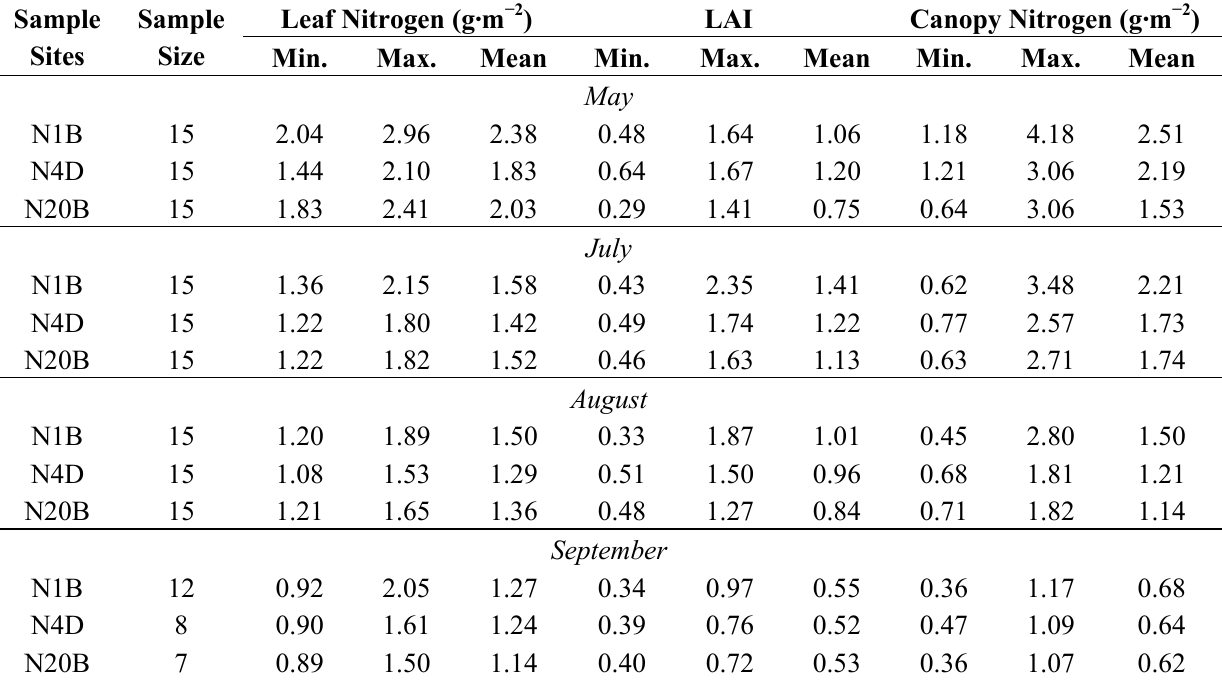
Table 2. Descriptive statistics of in situ N leaf , LAI and N can